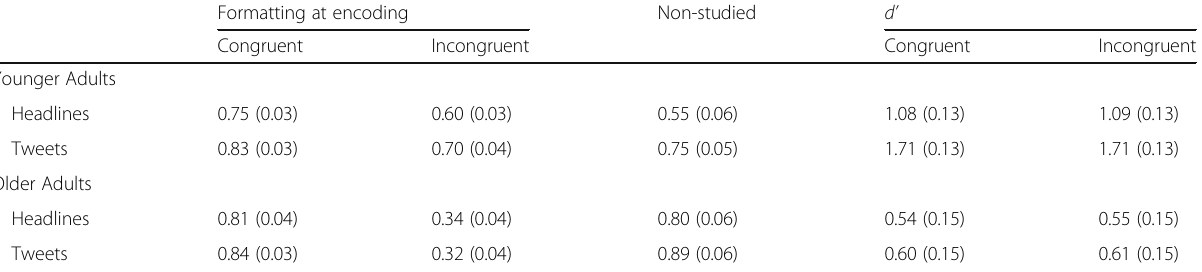
Table 4 Proportion of sources correctly identified and signal detection parameters as a function of age, item content, and item